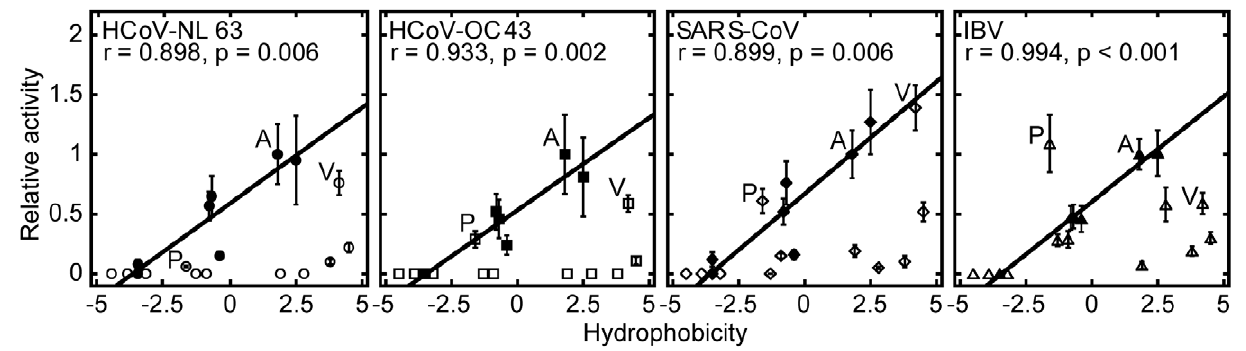
Figure 3. All 3CL pro prefer small hydrophobic residues at P4 position. All 3CL pro activities are highly correlated to hydrophobicity of residues with side chain volumes of , 70 A˚ 3 (filled symbols). The correlation coefficients and the corresponding p-values are indicated.